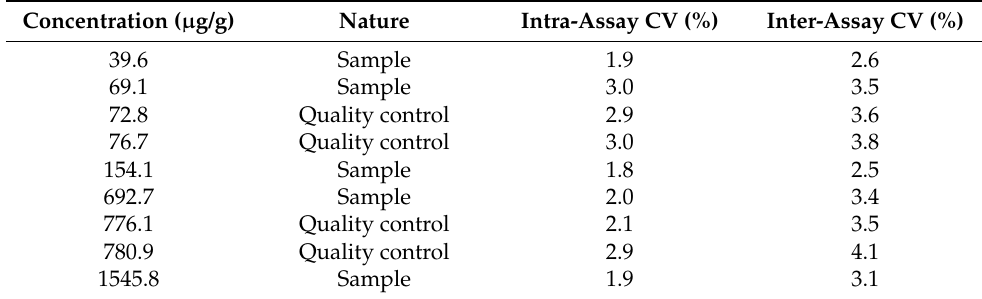
Table 1. Repeatability of the IDS